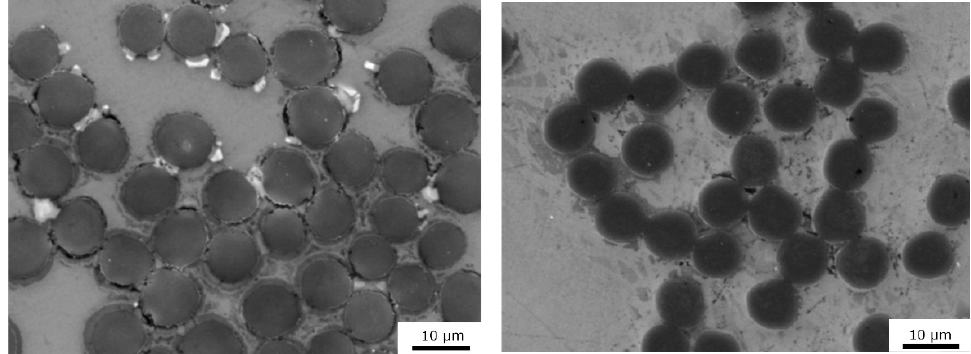
Figure 13. SEM images of Mg1.8Y/Granoc ( left ) and Mg2Li/Granoc ( right ) composites after thermal exposition in the DMA apparatus.